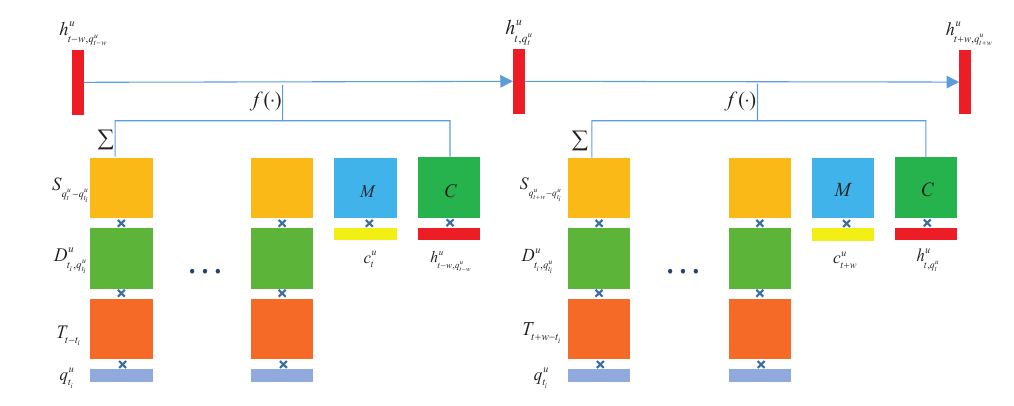
Figure 1. Diagram of MST-RNN